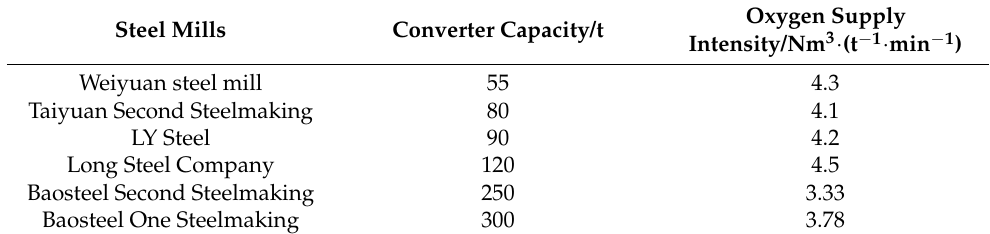
Table 7. Oxygen supply intensity of different capacity